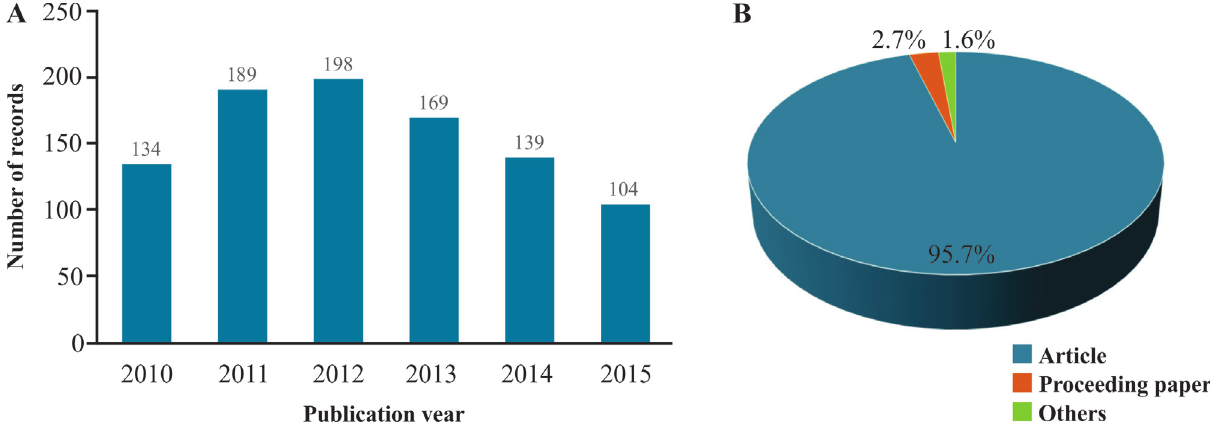
Figure 3 - Number of publications relating to the use of microsatellites in crop genetic studies from 2010 to 2015 according to the Web of Science data- base (A). Distribution of records according to the type of publication